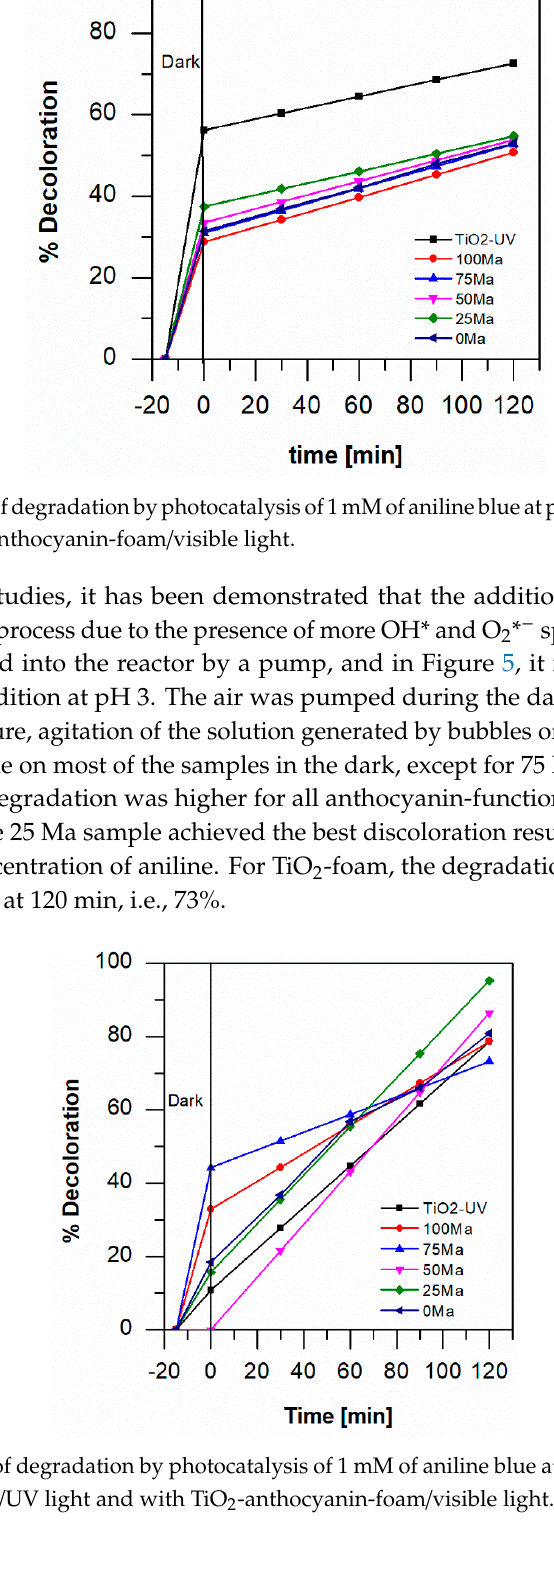
Figure 6. Percentage of degradation by photocatalysis of 1 mM aniline blue for the 25 Ma sample at pH 7 and pH 3 with and without the injection of air. The kinetic study of the degradation of aniline blue showed that the reaction follows a pseudo- first-order kinetic behavior (see Figure 7). As in most studies on the photocatalytic degradation of dye with metallic oxides, this system follows the Langmuir-Hinshelwood model, in which ln(C/C 0 ) = − kt, where C 0 is the initial concentration of the dye, C is the concentration every 30 min, t is the time, and k is the rate of degradation. At pH 7, the 25 Ma sample produced faster degradation, and at pH 3, the TiO 2 foam was faster. At pH 3 with O 2 , 25 Ma and 50 Ma were the fastest (see Figure 7). In Table 2, it shows the rate values obtained for every type of sample in study.